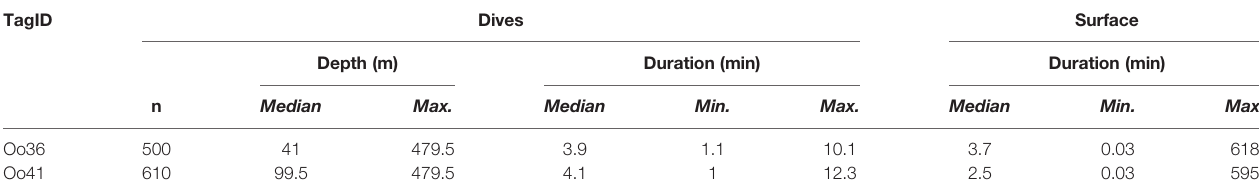
TABLE 3 | Dive and surfacing summary of the two SPLASH10-A tagged whales that reported data.